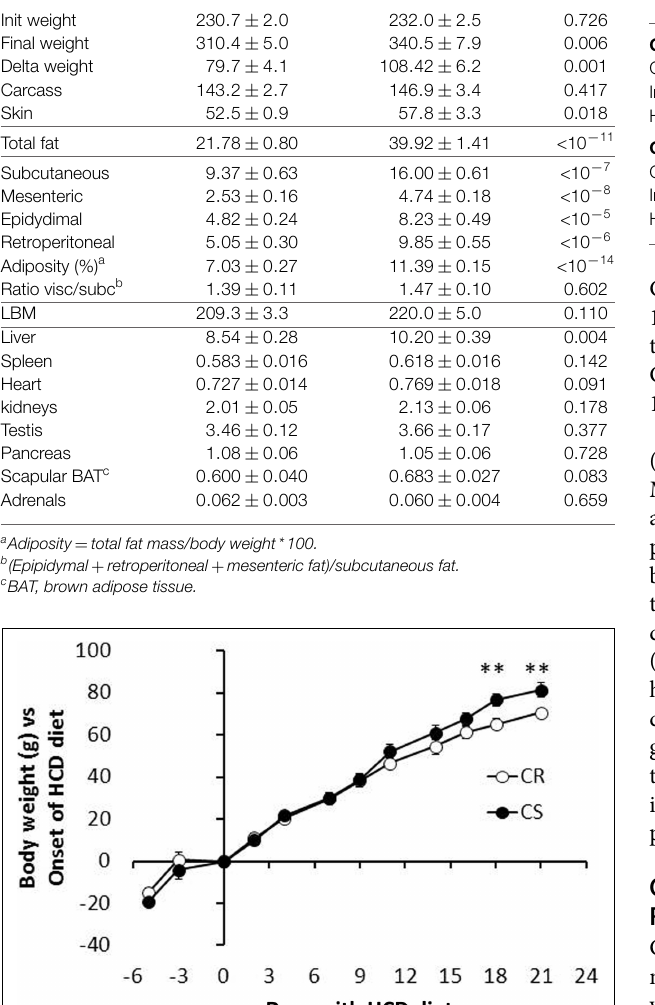
Response to GTT Changes in glucose and lipid oxidation in response to GTT were measured by indirect calorimetry on 15 rats, among which four were a posteriori classified as CR (final adiposity 6.53 (cid:6) 0.44%) and six as CS (final adiposity 11.26 (cid:6) 0.2%). The GTT induced an increase in glucose oxidation that peaked between 30 and 60 min, then returned to basal levels within 120 min ( Figure 4 ), a kinetic that closely paralleled the changes observed in blood glucose ( Figure 3 ). Changes in Lox mirrored the changes in Gox but were of smaller amplitude and duration.